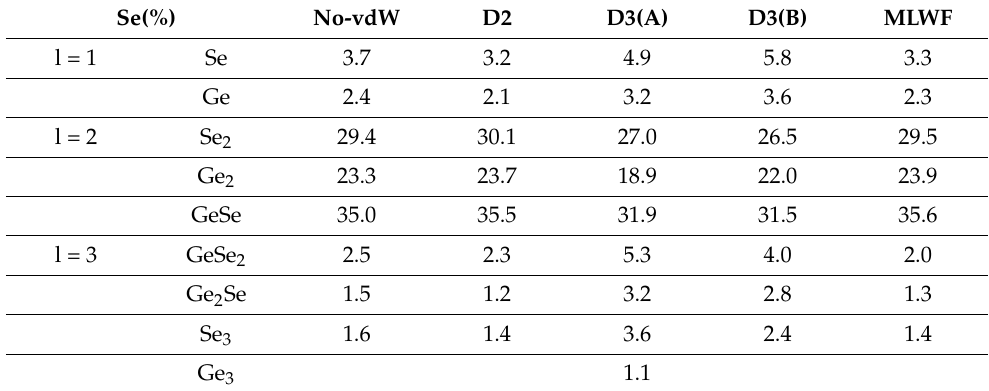
Table 3. Structural units composing the Se-based subnetwork of liquid GeSe 4 . The values given are the percentages of Se atoms connected in onefold, twofold, and threefold fashion, the chemical nature of the different neighbors being specified in the second